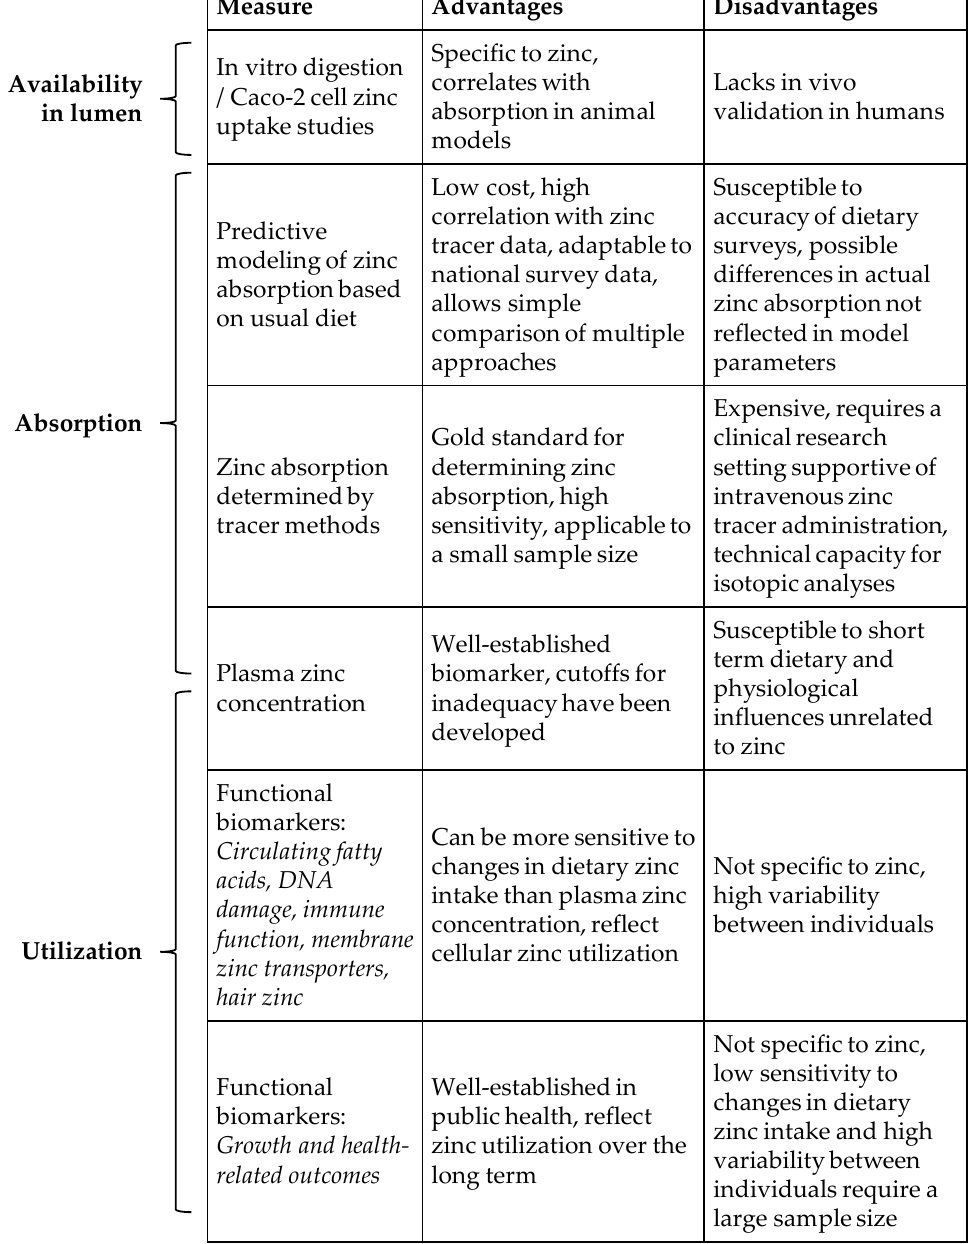
Figure 1. Comparison of zinc measures and relation to bioavailability.